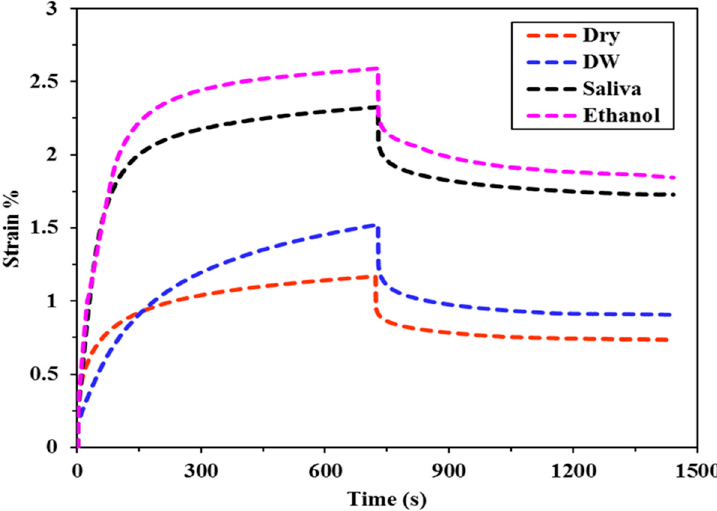
Figure 2. Creep deformation and recovery of FBF in various food simulating organic solvents (FSOS).